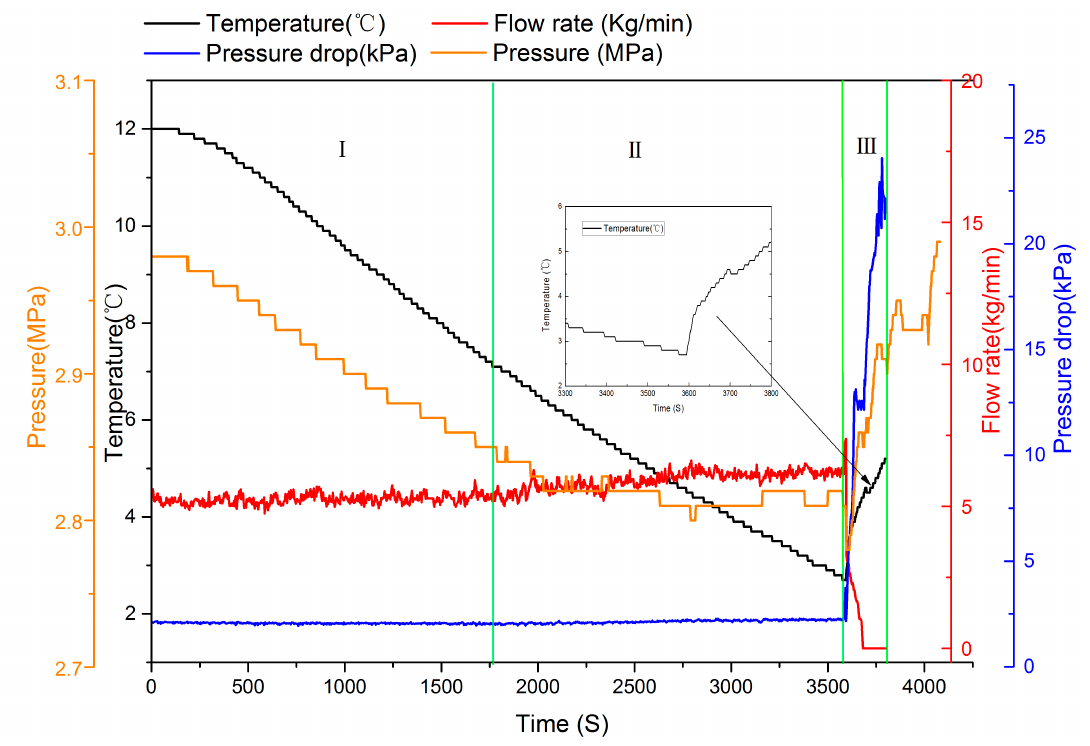
Figure 3. At a pressure of 3 MPa, a temperature of 1.5 °C and a water cut of 60%; the temperature, flow rate and pressure drop with time